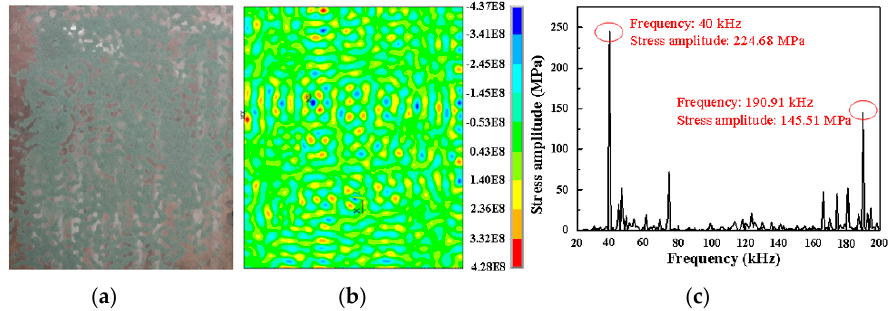
Figure 12. Vibration shape and amplitude curve at the copper plate surface under ultrasonic excitation. ( a ) Actual vibration shape; ( b ) simulation vibration shape; ( c ) amplitude-frequency curve.